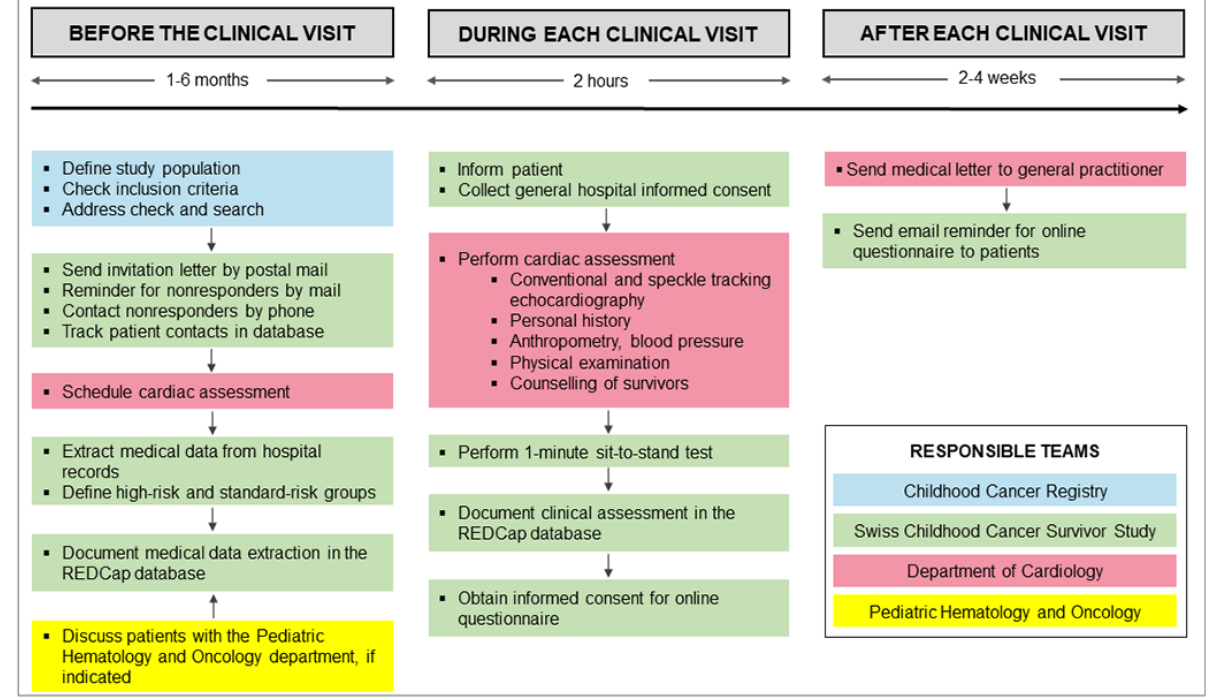
Figure 1. Responsible teams in the study of preclinical diagnosis of cardiac dysfunction in childhood cancer